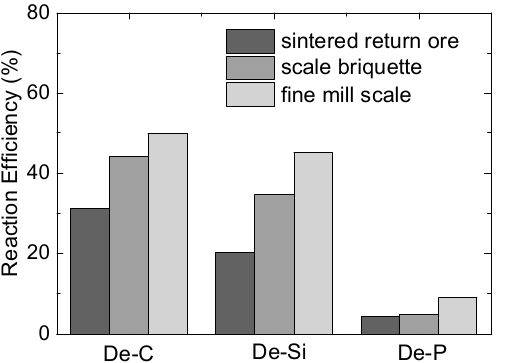
Figure 4. Decarburisation, desiliconisation and dephosphorisation reaction efficiencies of various solid oxygen materials.